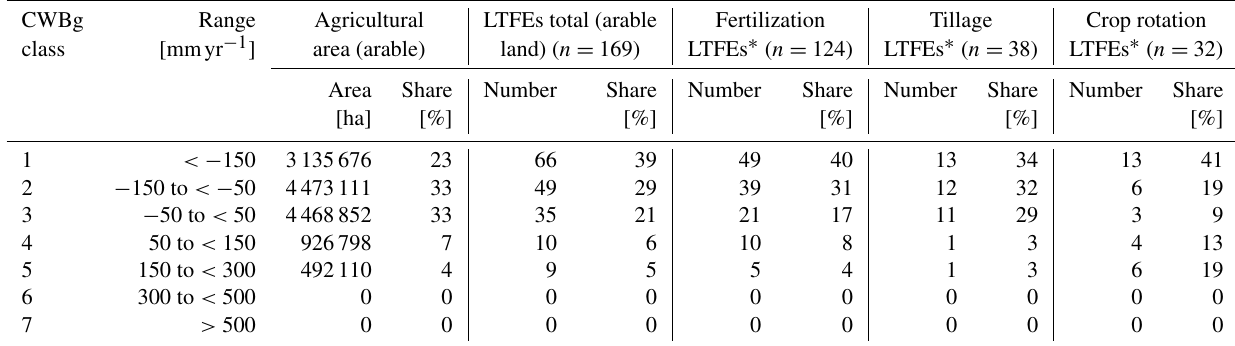
Table 2. Climatic water balance of the growing season (1 May to 31 October) (CWBg) classification of arable land in Germany and the number and share of the different LTFE types in each CWBg class.